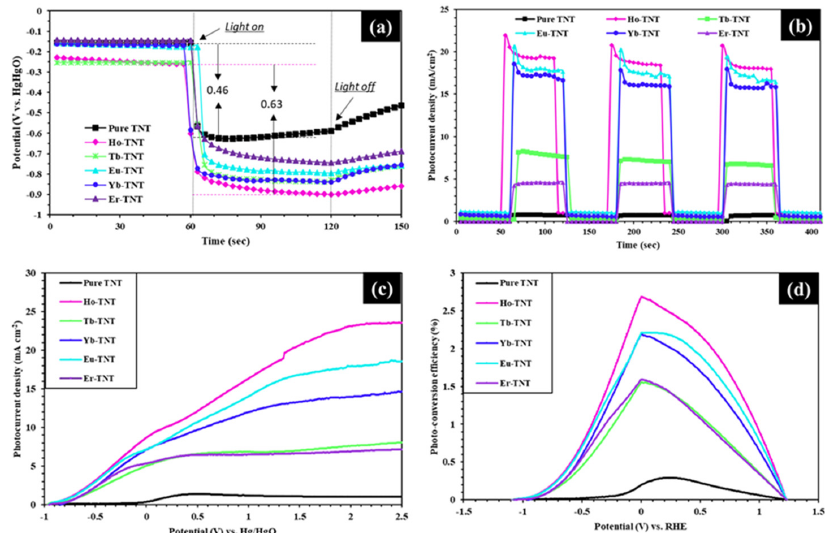
Figure 7. Photoelectrochemical characterization of as-prepared samples. ( a ) Open-circuit voltage (OCP), ( b ) chronoamperometry, ( c ) linear sweep voltammetry (LSV), and ( d ) photo-conversion efficiency (PCE).